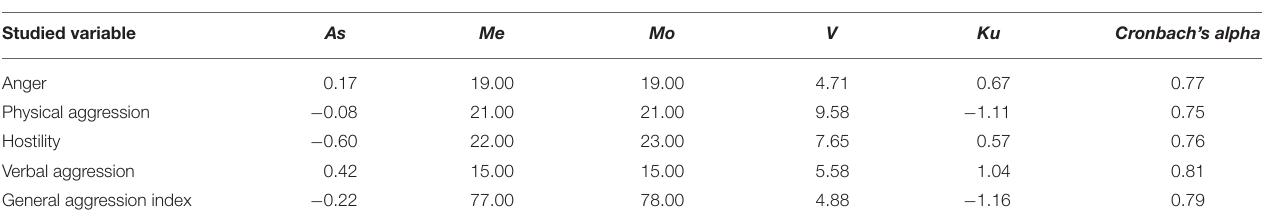
TABLE 1 | Skewness, kurtosis and Cronbach’s alpha values. Studied